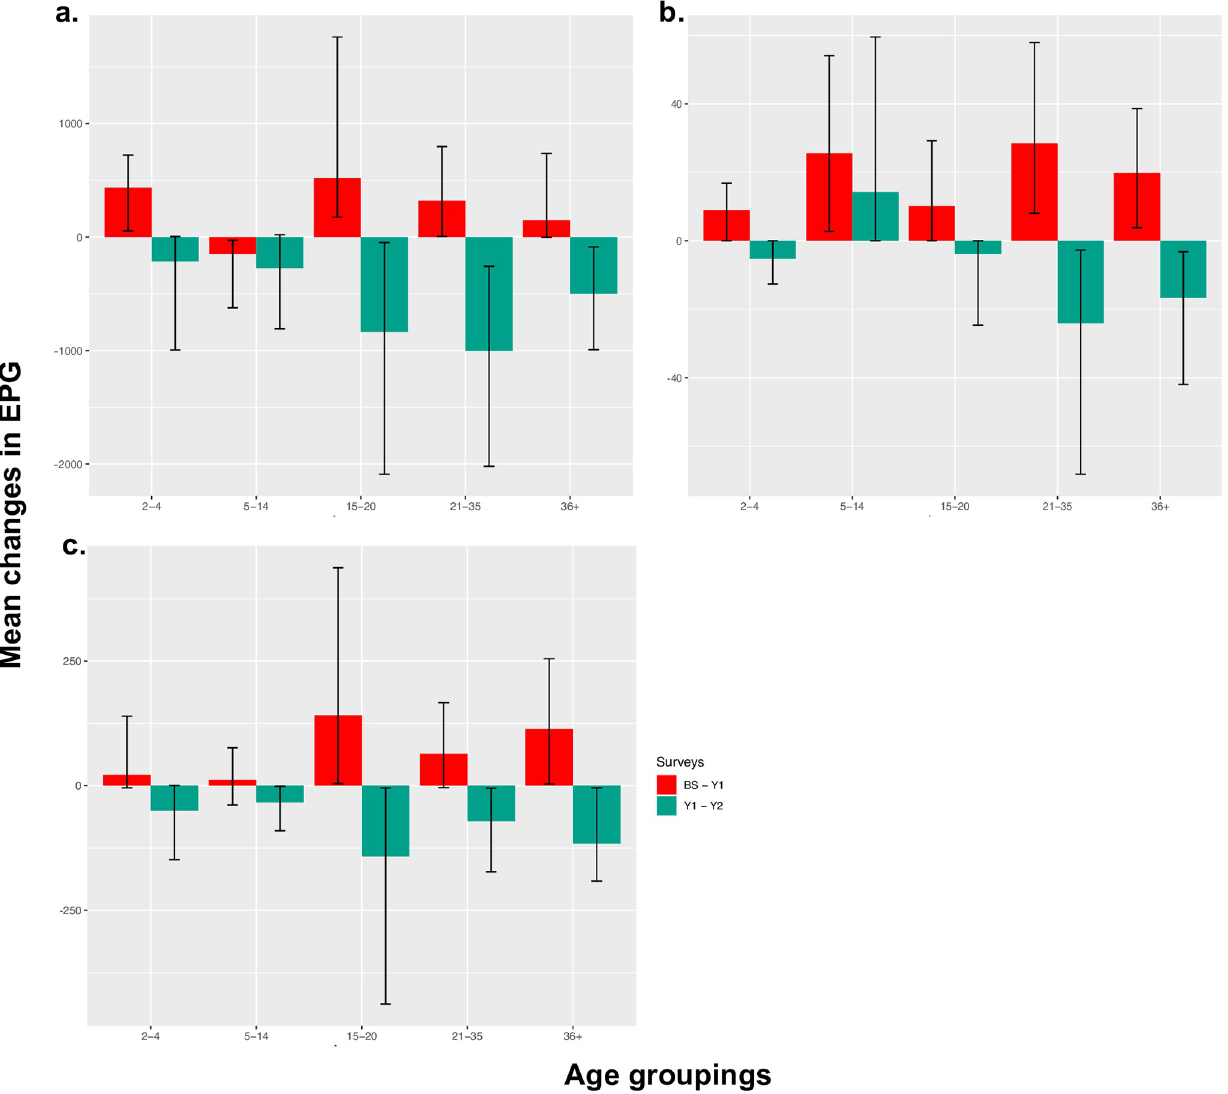
Fig 4. Mean changes in eggs per gram of faeces (EPG) by age group. Red bars = mean change in EPG BS–Y1. Green bars = mean change in EPG Y1 –Y2. Vertical lines represent 95% confidence intervals. Each plot represents age stratified mean epg changes across all three STH species; a . A . lumbricoides , b . Hookworm and c . T . trichiura